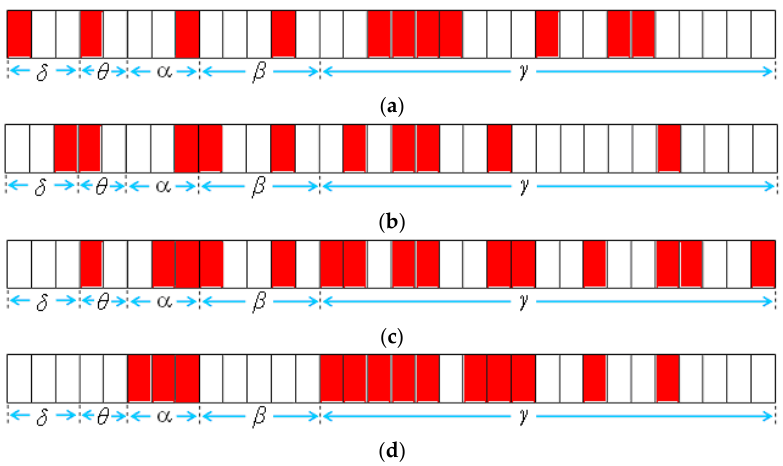
Figure 10. Feature vectors selected by ( a ) IG; ( b ) SFS; ( c ) SFFS; ( d ) NRFS. Table 6. Experimental results of noisy data set of EEG signals.